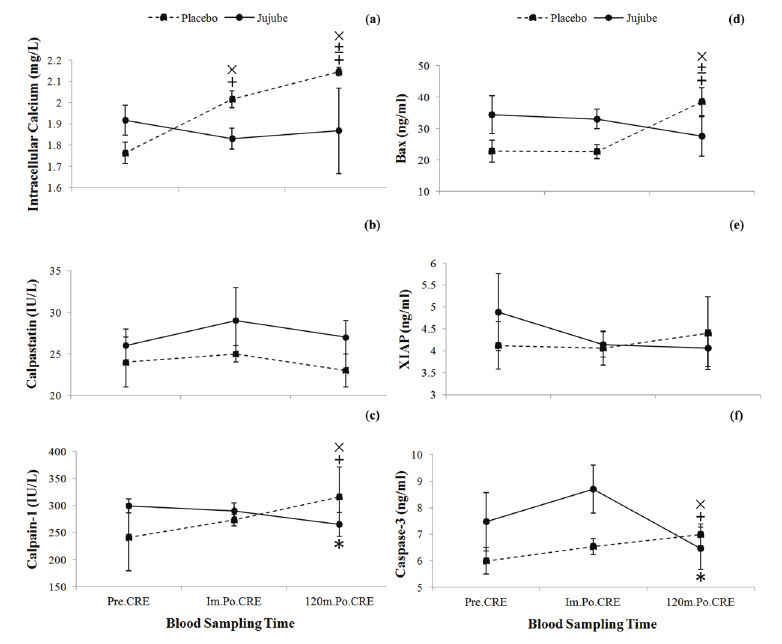
Figure 3. The Effect of One Week Supplementation with Ziziphus jujuba on some Pro- and Anti-Apoptotic Protein Levels of Human Neutrophils in Response to a Session of Circuit Resistance Exercise (a) Effect on intracellular calcium levels (b) Effect on Calpastatin